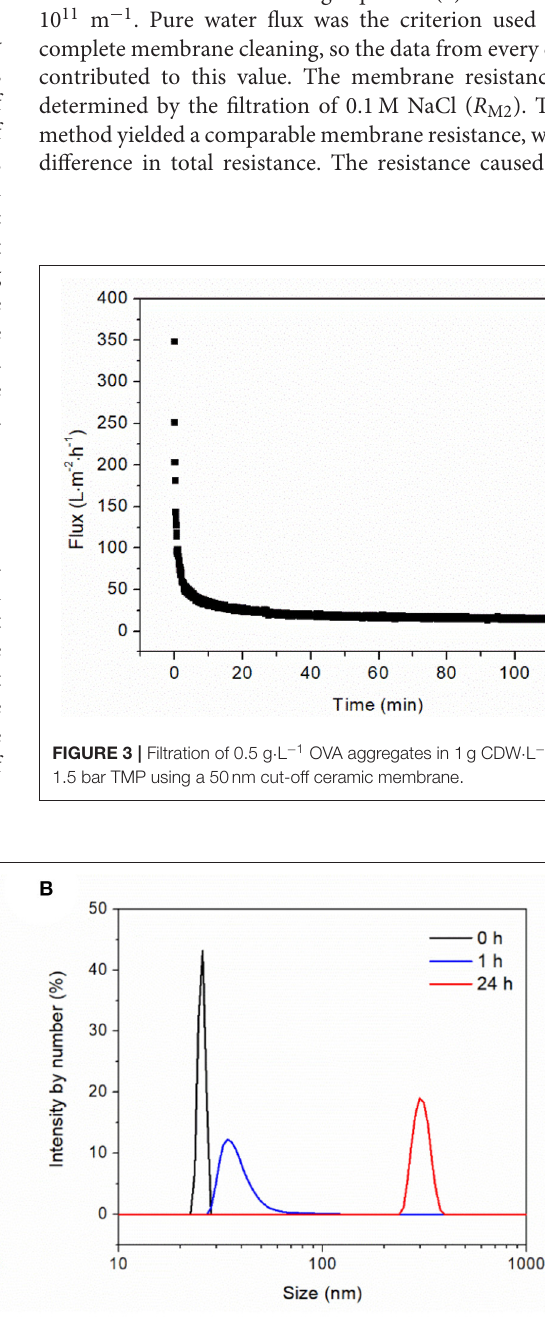
Frontiers in Chemical Engineering |